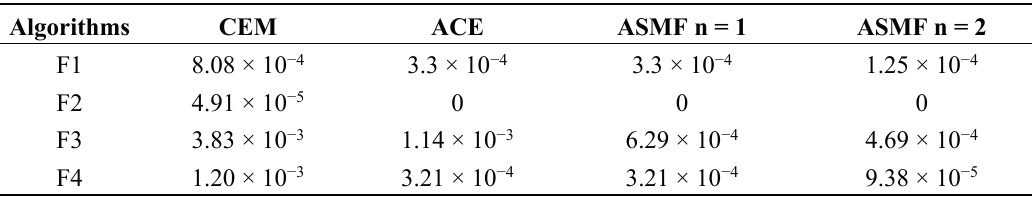
Figure 18. ROC curves corresponding to Figure 17 of ( a ) F1, ( b ) F2, ( c ) F3, and ( d ) F4. Table 4. FARs under 100%